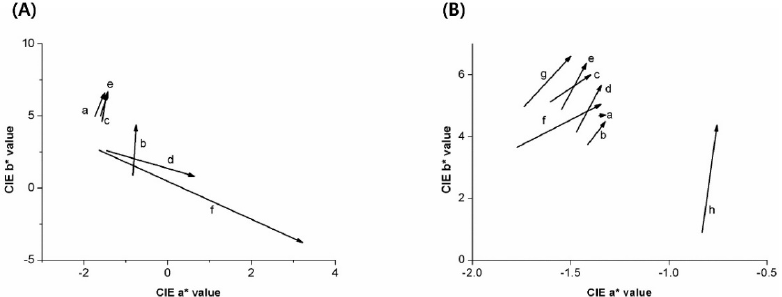
Figure 1. Mean a* and b* values changed from one week to four weeks (arrowhead) according to concentrations of ethanol and pigment ( A ), according to pH and concentration of pigment ( B ). ( A ) pH 5.5 solutions with ethanol 0 and pigment 0 ( a ); ethanol 0 and pigment 12.5% ( b ); ethanol 20% and pigment 0 ( c ); ethanol 20% and pigment 12.5% ( d ); ethanol 40% and pigment 0 ( e ); ethanol 40% and pigment 12.5% ( f ). Without pigment, storage in different ethanol concentrations ( a , c , e ) demonstrated similar patterns to storage solution with pigment and no ethanol ( b ), the color changed to increased redness and yellowness. However, color changed towards redness and blueness when both pigment and ethanol was used ( d , f ). ( B ) Non-ethanol solutions with pH 2 and pigment 0 ( a ); pH 2 and pigment 12.5% ( b ); pH 3 and pigment 0 ( c ); pH 3 and pigment 12.5% ( d ); pH 4 and pigment 0 ( e ); pH 4 and pigment 12.5% ( f ); pH 5.5 and pigment 0 ( g ); pH 5.5 and pigment 12.5% ( h ). At the same pH, the color change, which was towards increased redness and yellowness, was more severe when the pigment was added ( a – h ).